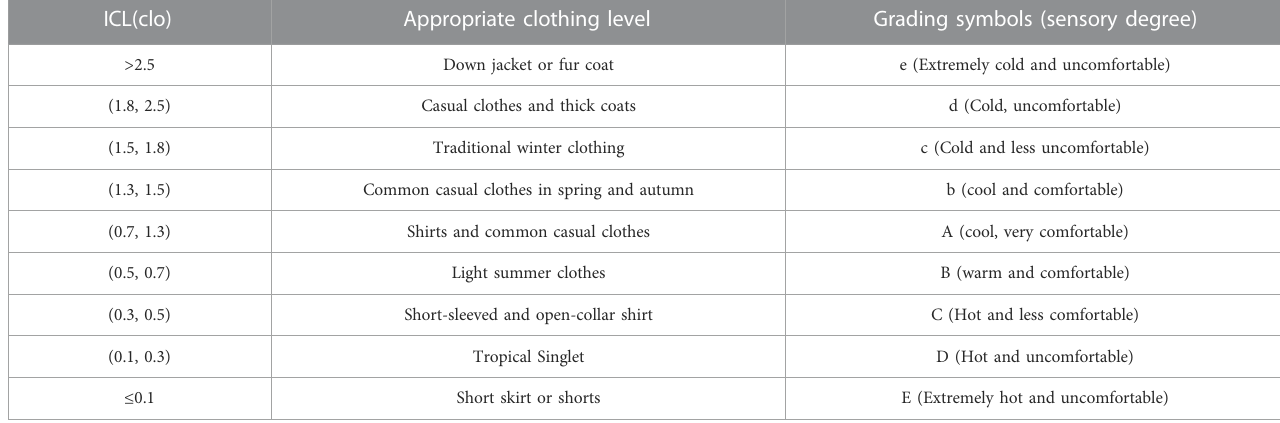
TABLE 3 Grading standards and appropriate clothing level for ICL (Ma et al.,